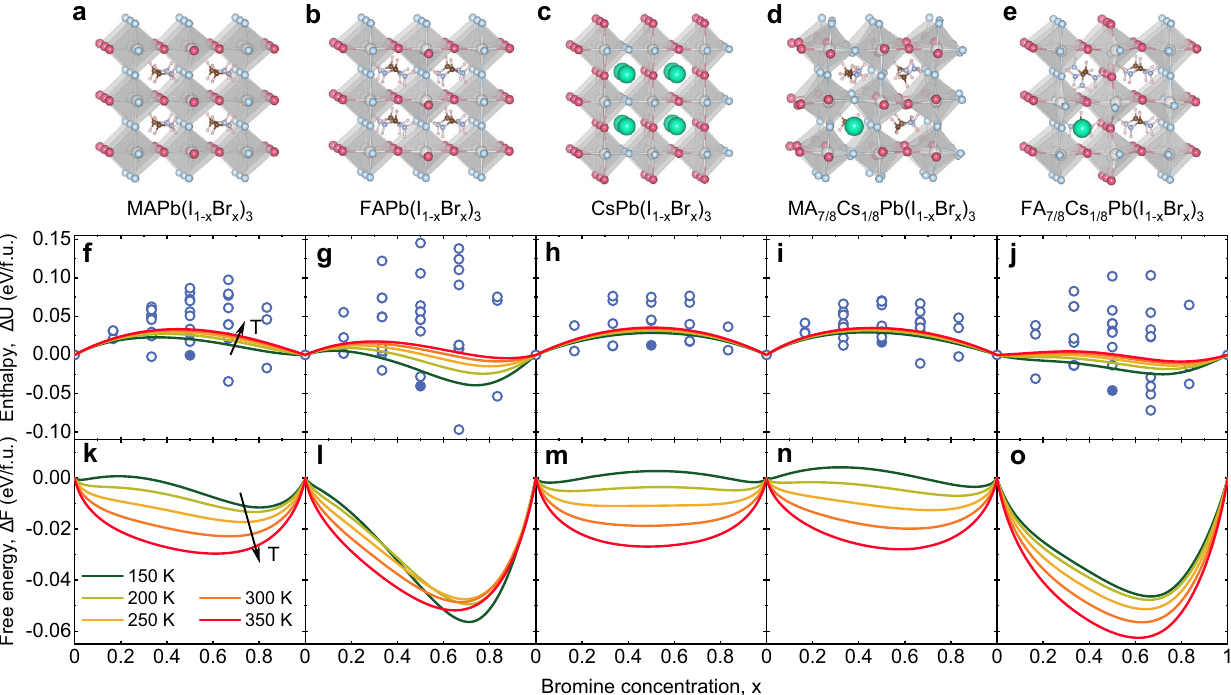
Fig. 1 Mixing enthalpy and free energy of mixed I/Br perovskites in the dark. a – e Atomic structures of the most stable con fi gurations of the different compounds at relative Br concentration x = 0.5. Red spheres: I. Blue spheres: Br. White spheres inside octahedra: Pb. Green spheres: Cs. Cationic molecules in between octahedra: methylammonium (MA) or formamidinium (FA). f – j Mixing enthalpy per formula unit (f.u.) as a function of Br concentration. Circles: values calculated for each mixed con fi guration. Filled circles: values for the most stable con fi gurations at x = 0.5, displayed in ( a – e ). Curves: results for the quasi-chemical approximation (QCA) at different temperatures. k – o Mixing free energy per formula unit as a function of Br concentration.